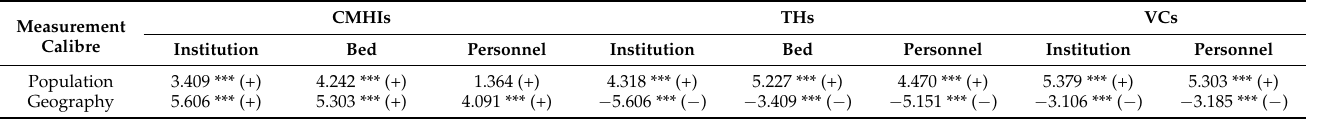
Table 2. Mann–Kendall test results of the Gini coefficient (CMHIs: county and county-level city medical and health institutions; THs: township hospitals; VCs: village clinics). CMHIs Measurement Calibre